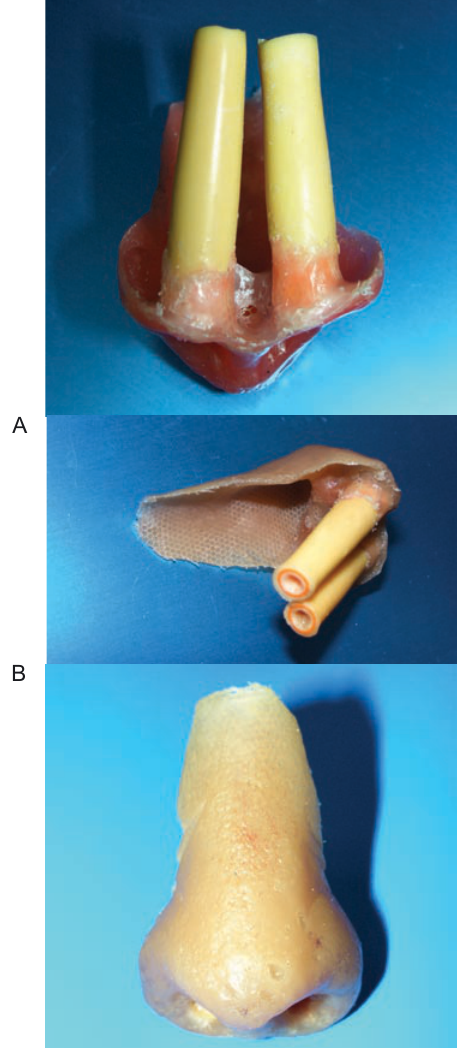
Figure 1. Appearance of nasal prosthesis with retainer; A, Back side, B, Front side.